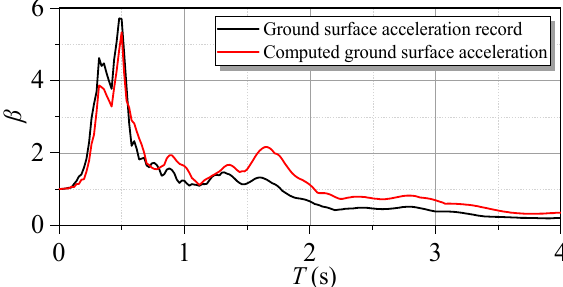
Figure 9. Computed ground surface acceleration time history.